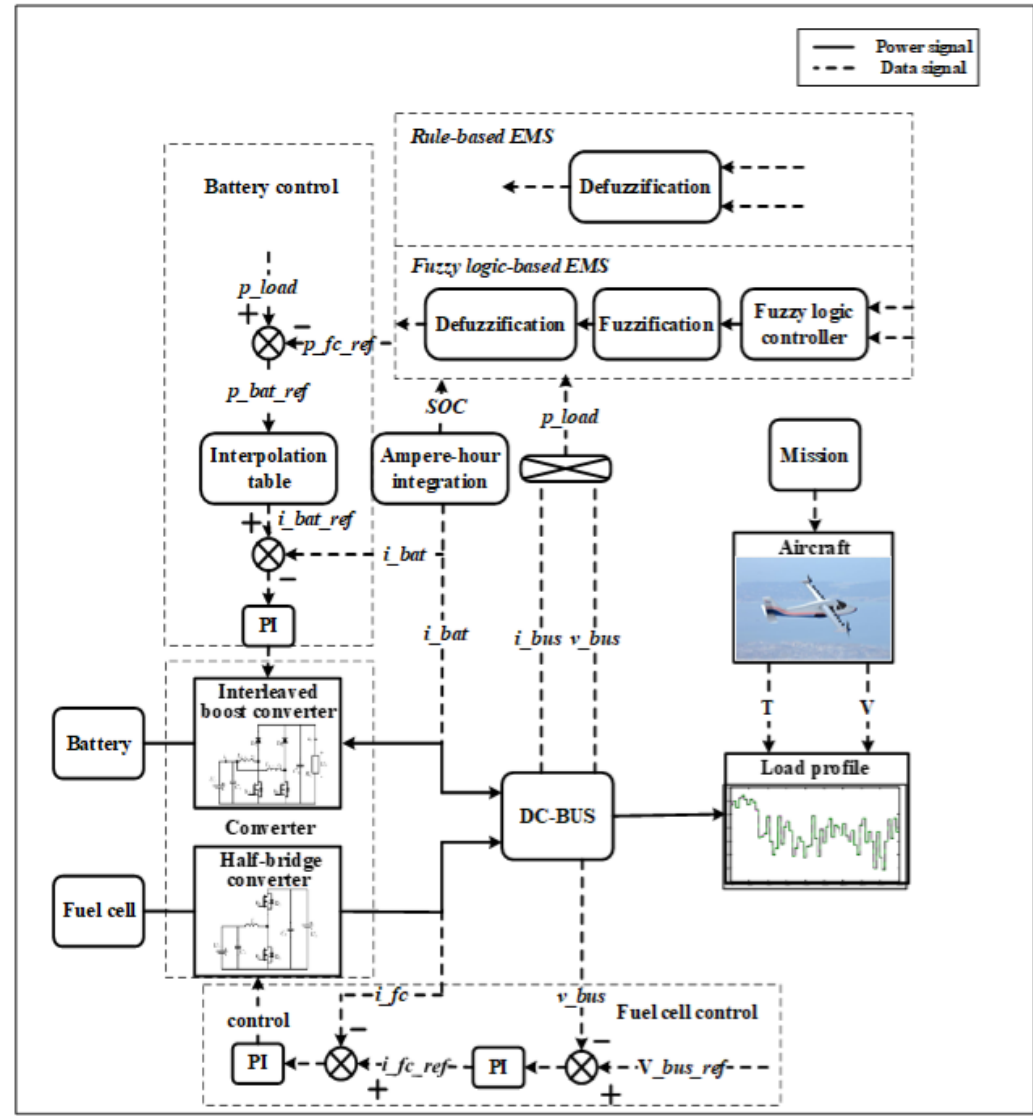
Figure 8. Block diagram of the energy management system for HEPS.